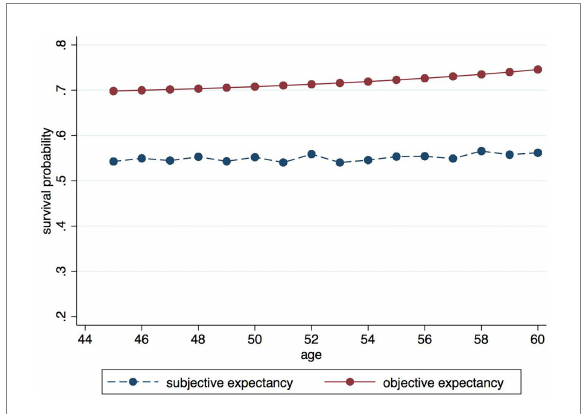
FIGURE 2 Comparison of subjective life expectancy and objective survival years.